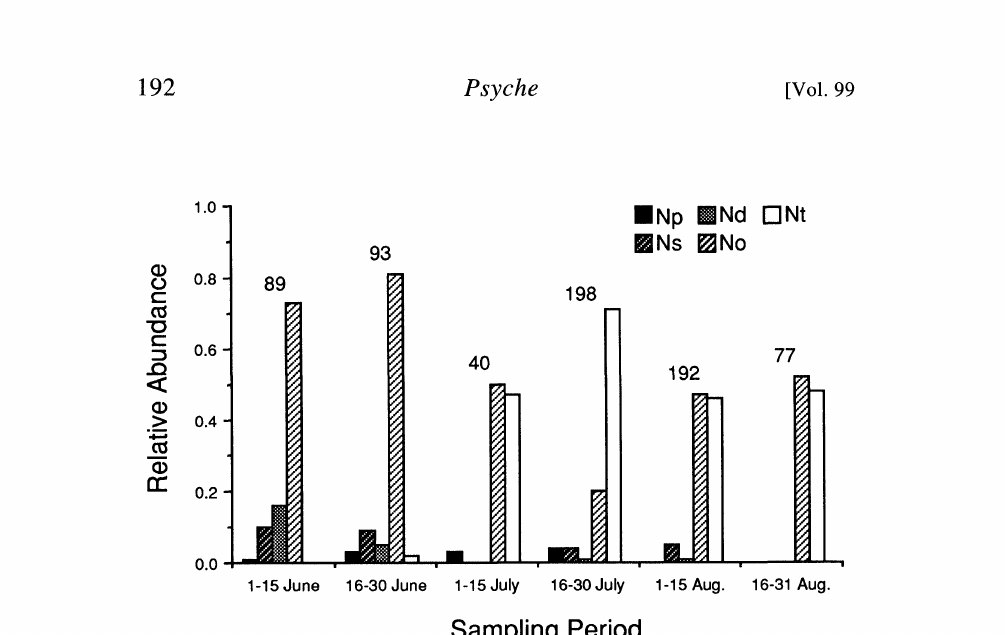
Figure 1. Relative abundances of Nicrophorus species. Sample sizes are shown above the bars. Np N. pustulatus, Ns N. sayi, Nd N. defodiens, No N. orbicollis, Nt N.